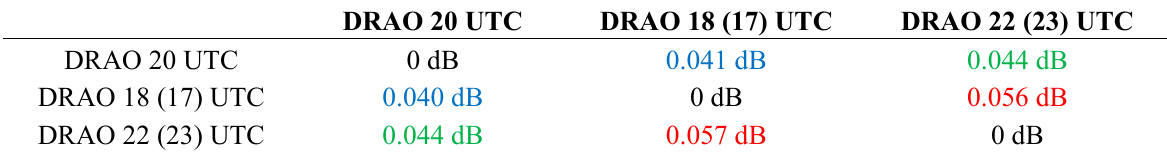
Table 1. Agreement in terms of scatter (in dB) between the three 1-h long Sun measurements acquired by the DRAO in